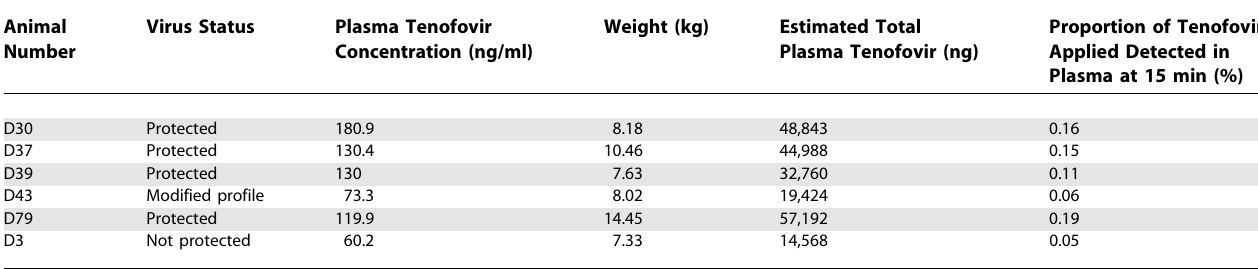
Table 5. Plasma Tenofovir Levels and Association with Protection from Infection Animal Virus Status Plasma Tenofovir Weight (kg) Estimated Total Number Concentration (ng/ml) Plasma Tenofovir